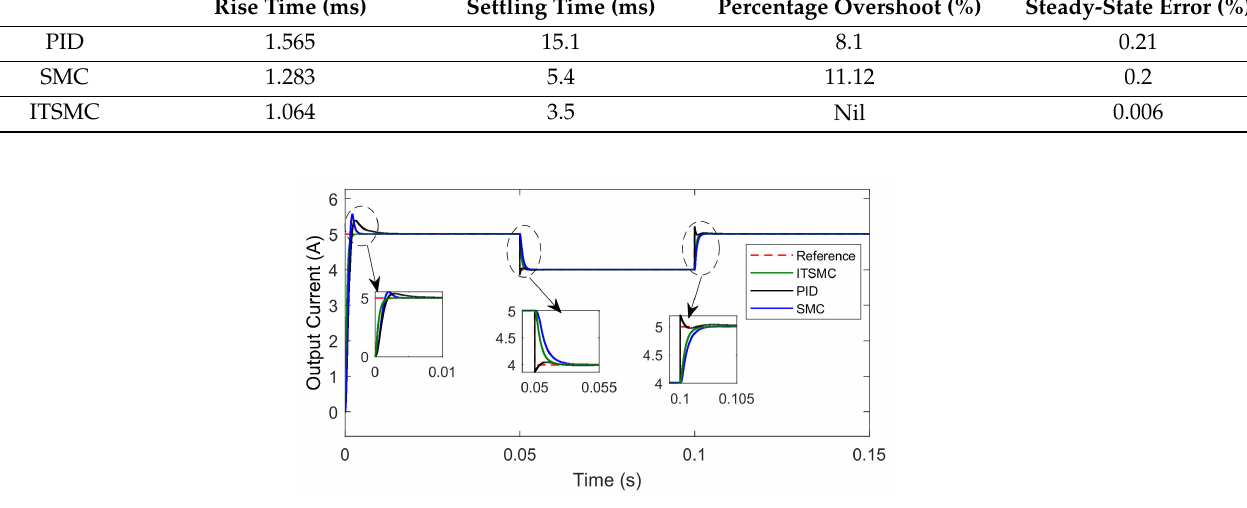
Figure 16. Tracking of I sc , during perturbation in I scref